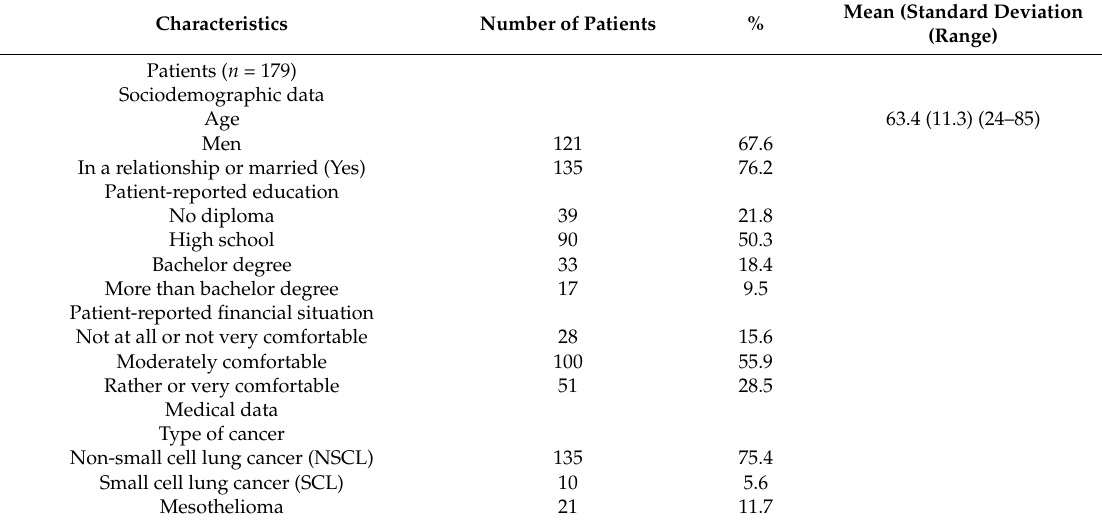
Table 1. Descriptive